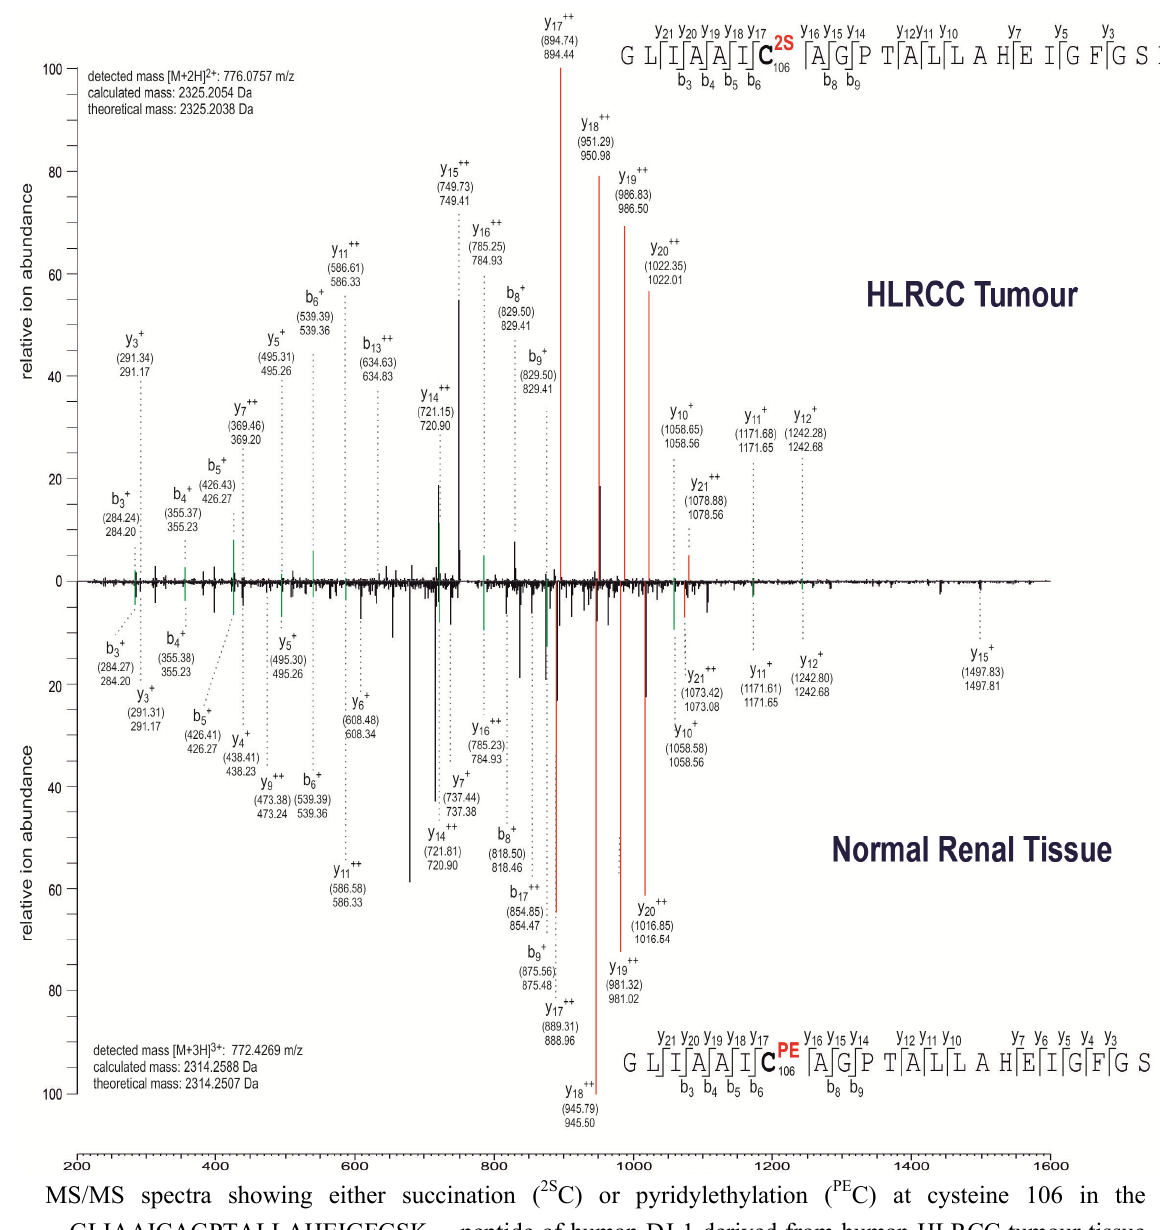
Figure 2. MS/MS spectra showing succination of the active site (C106) of